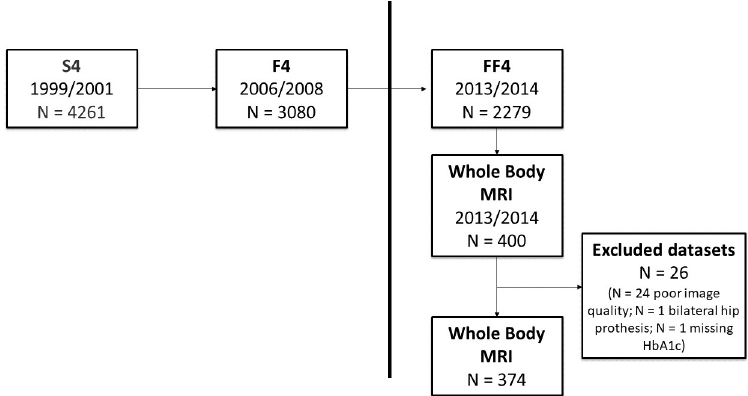
Fig 5. Flow chart of study participant selection. The vertical line represents the initial KORA-study with baseline examinations between 1999 and 2001 (S4 = Exam 1), first follow up between 2006 and 2008 (F4 = Exam 2) and second follow up between 2013 and 2014 (FF4 = Exam 3). Of the participants of the FF4 study, 400 were randomly selected to participate in the MRI sub-study (vertical line), and 26 subjects were excluded.